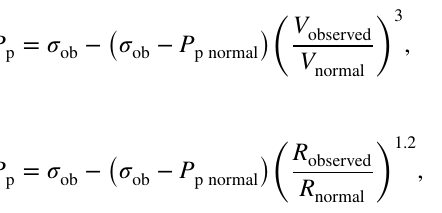
Fig. 3 Stratigraphy and petroleum system of Tripura, Assam–Arakan basin (the red intervals highlighted above reflect the gross intervals within which multiple pays are producing). The range of pays varies